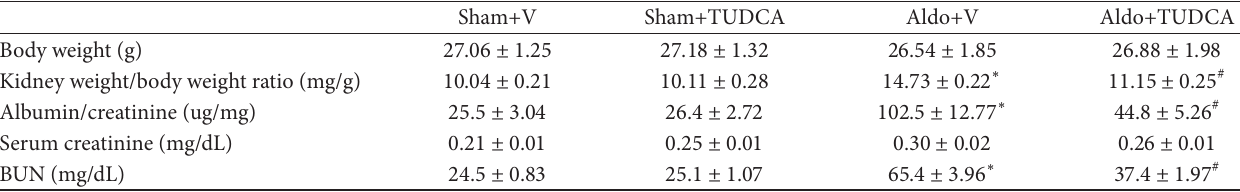
Table 2: Biological parameters in Aldo-infused mice at week 4.